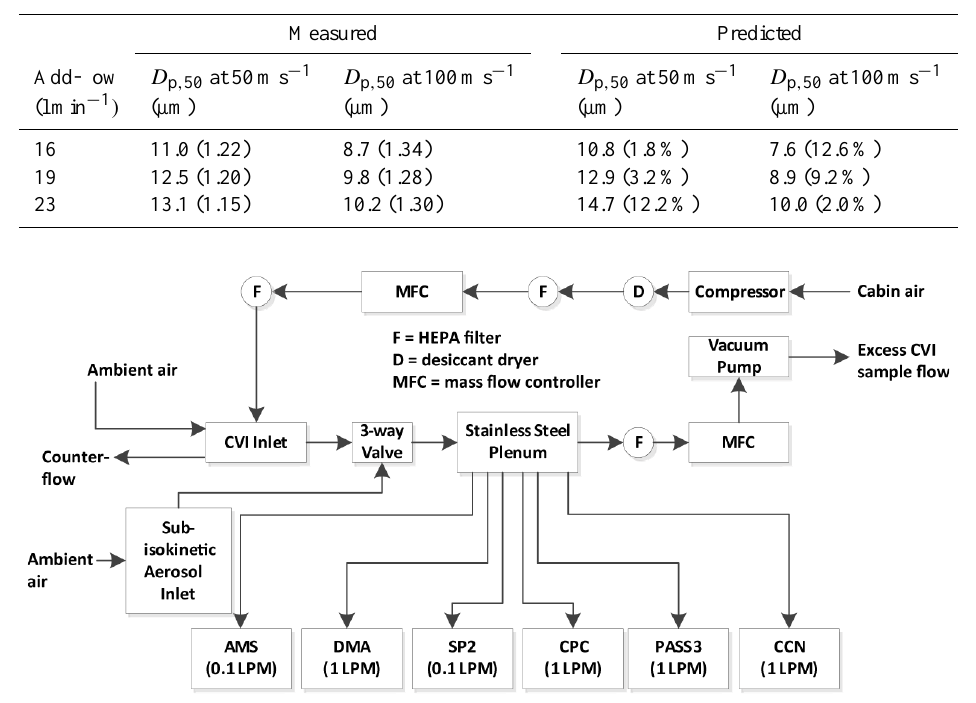
Fig. 5. Schematic of the sample air flow path through both the sub-isokinetic aerosol inlet (clear air sampling) and the CVI (in-cloud sampling) on the CIRPAS Twin Otter during the 2011 E-PEACE experiment. Six instruments characterised aerosol physicochemical prop- erties downstream of the CVI inlet with their respective flow rates shown (total=4.2lmin − 1 ) . As the total sample flow rate provided was 15lmin − 1 , the excess sample flow (10.8lmin − 1 ) was diverted out of the aircraft by a vacuum pump.